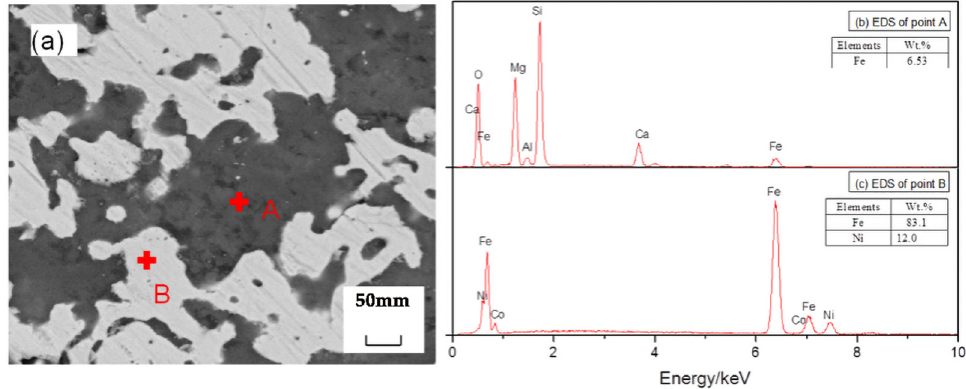
Figure 12. SEM/EDS analysis of reduction samples under the action of calcium fluoride and ferro- nickel concentrate; ( a ) scanning electron microscope image, ( b ) EDS spectrum of spot A in image ( a ), ( c ) EDS spectrum of spot B in image ( a ).